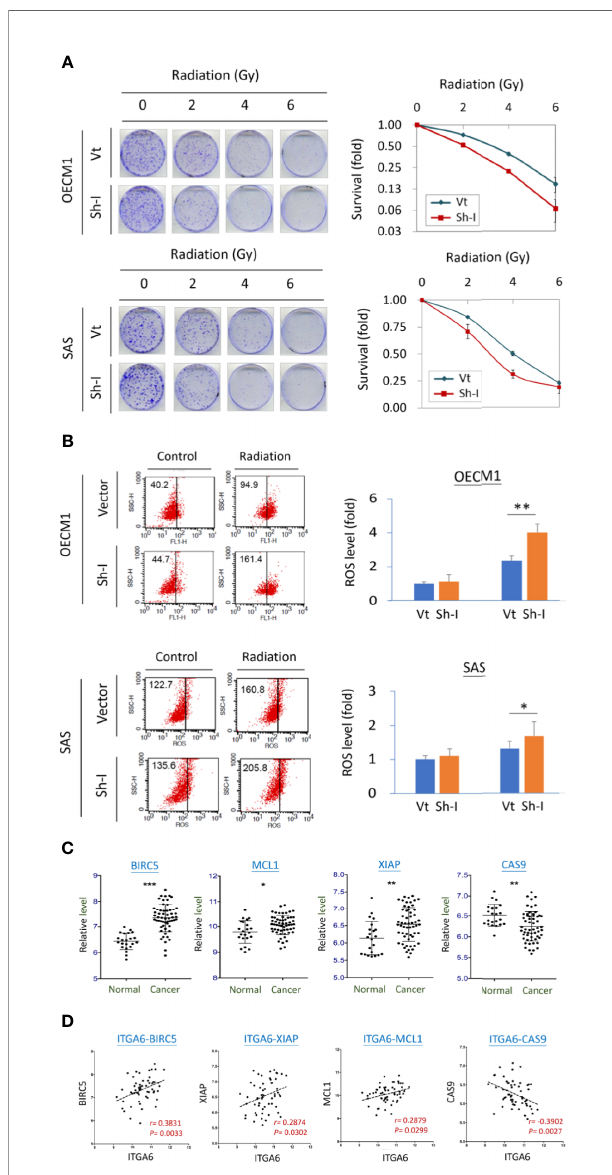
FIGURE 6 | ITGA6 facilitated radioresistance through regulation of the apoptotic related mechanism. (A) ITGA6 silencing increased radiosensitivity. After transfection of ITGA6-shRNA plasmids, the HNC cells (OECM1, SAS) were subjected to clonogenic survival assay. The colony survival fractions were determined after the cells were irradiated with various doses (0 to 6 Gy). (B) ITGA6 silencing increased ROS production in HNC cells. After transfection ITGA6-shRNA plasmids, the HNC cells (OECM1, SAS) were subjected to irradiation. The ROS level was determined using H2DCF-DA oxidation method and analyzed by fl ow cytometry. (C) Signi fi cantly higher expressions of survival related genes (BIRC5, MCL1, XIAP) and lower expression of apoptotic gene (CAS9) in the oral cancer tissues from HNC patients (Cancer) compared to the oral mucosa specimens from healthy individuals (Normal). The gene expression data was retrieved from GEO Datasets GSE25099. (***p < 0.001, **p < 0.01, *p < 0.05, t-test). (D) Correlative expressions between ITGA6 and survival or apoptotic associated molecules BIRC5, MCL1, XIAP, and CAS9, in the oral cancer tissues from HNC patients. The gene expression data was retrieved from GEO Datasets